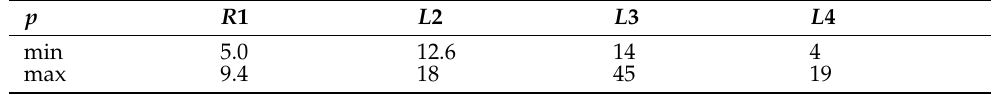
Table 6. Bounds of the design variables for TEAM Problem